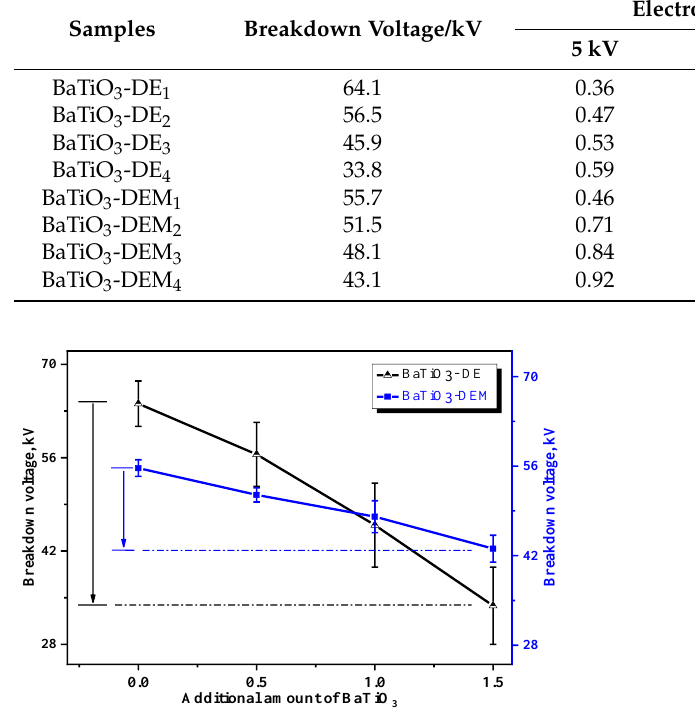
Table 8. Breakdown voltage and electrostrictive strain between two kinds of samples.